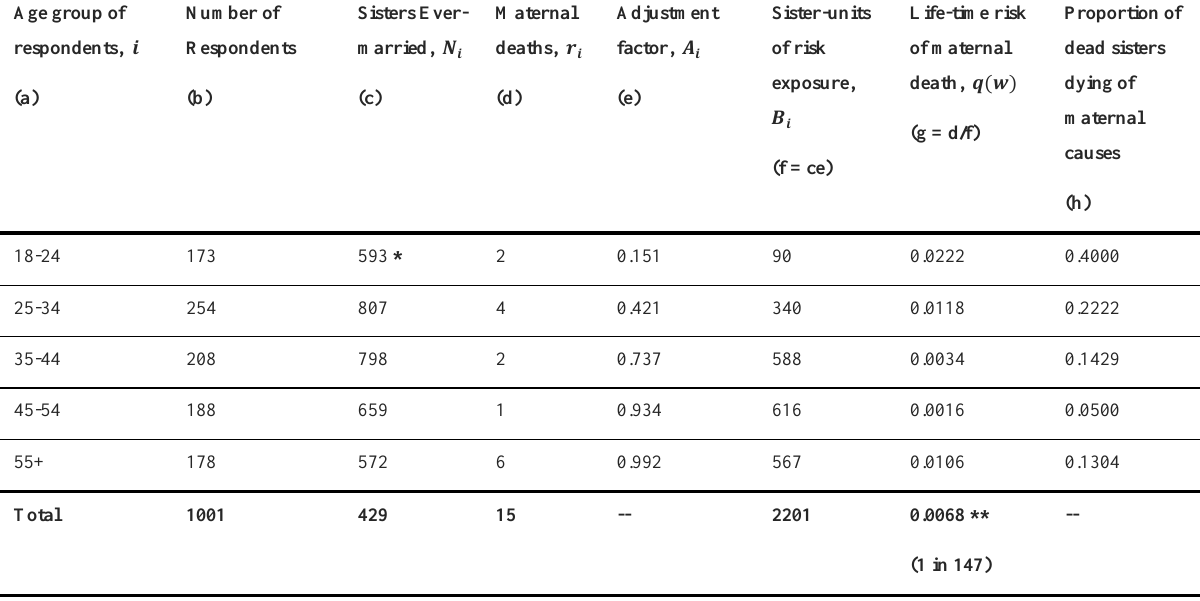
* Derived for age 18-24 by multiplying the # of respondents 18-24 (n=173) by the average number of ever married sisters per respondent for age groups 25+ (3.425). This corrects for under-estimation of the number of total sisters for young respondents (Graham, 1989). Reported number of ever married for respondents 18-24 is Table 1. Estimation of maternal mortality using the Sisterhood method for GBAO Tajikistan, 2006. and the probability of dying from those causes. 2 We also The Maternal Mortality Ratio (MMR), is a applied a correction to the number of sisters at risk in the function of the lifetime mortality risk and the total younger respondent group by multiplying the number of fertility rate, MMR = 1 - P 1 TFR ⁄ , where P = 1 - Q, the respondents by the average number of sisters reported by lifetime probability of avoiding death from maternal older respondents (25 and older). This adjusts for under- causes, and TFR is the total fertility rate, the total number estimation of the number of total lifetime sisters for of children born per woman in her lifetime, or likely to young respondents. 3 Finally, because sample size was too be, if exposed to current rates of age-specific fertility. small to rely on age group estimates, the data were When lifetime cumulative risk, Q, remains constant or aggregated over all age groups to give the total lifetime increases in tandem with lower TFRs, the MMR ∑ B ⁄ risk of maternal death, Q = ∑ r increases, showing an increased risk of dying per i i 2]. To reduce the impact of potential reporting biases, we pregnancy. also followed Graham et al 2 in restricting respondent age Standard errors for Q were calculated as SE = Q to 49 and under, however, a maternal death of a sister is a very memorable event, 7 and we had no reason to believe limits of 95%, Q ±1.96(SE), were then substituted into the MMR equation to give upper and lower bounds on impaired. these estimates. 6 Time-lags using this method 2 also place